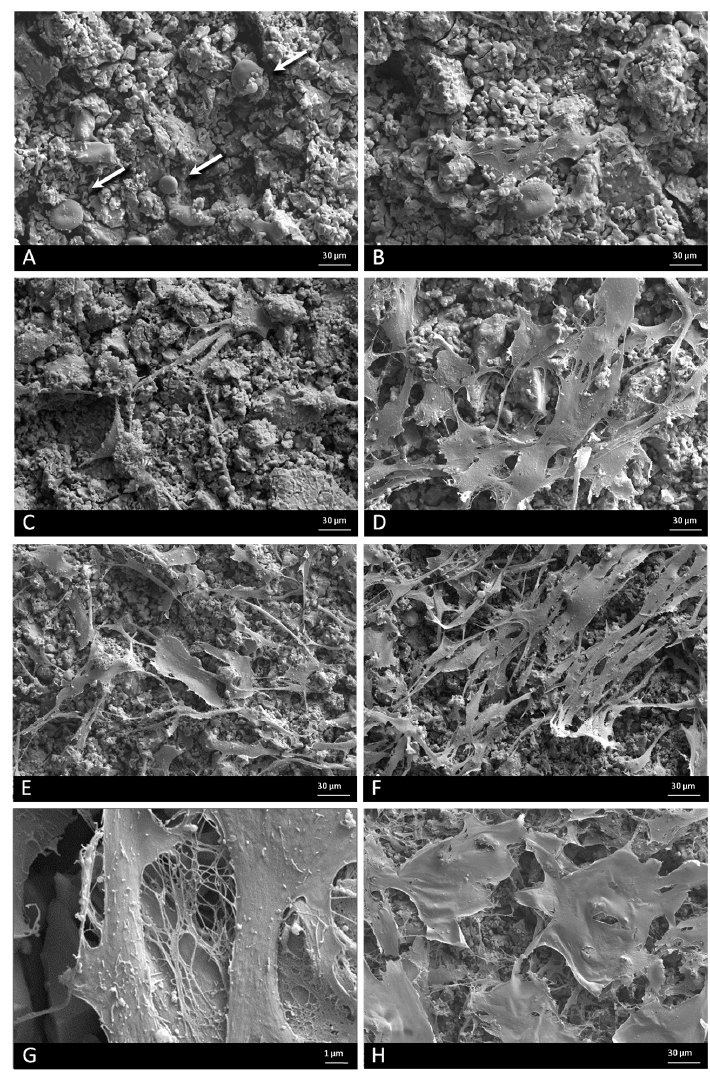
Figure 2. FESEM images of the ah MSCs cells grown on ceramic surfaces at 24 h ( A ) (300×) with rounded appearance (arrows), 3 days ( B ) (300×); 7 days ( C ) (300×); 14 days ( D ) (300×); 21 days ( E ) rounded appearance (arrows), 3 days ( B ) (300 × ); 7 days ( C ) (300 × ); 14 days ( D ) (300 × ); 21 days ( E (300×); 28 days ( F ) (300×) in GM and at 28 days in osteogenic differentiation medium (OM) ( H ) (300×) and collagen bundles occupying intercellular gaps at 28 days ( G ) (3000×).